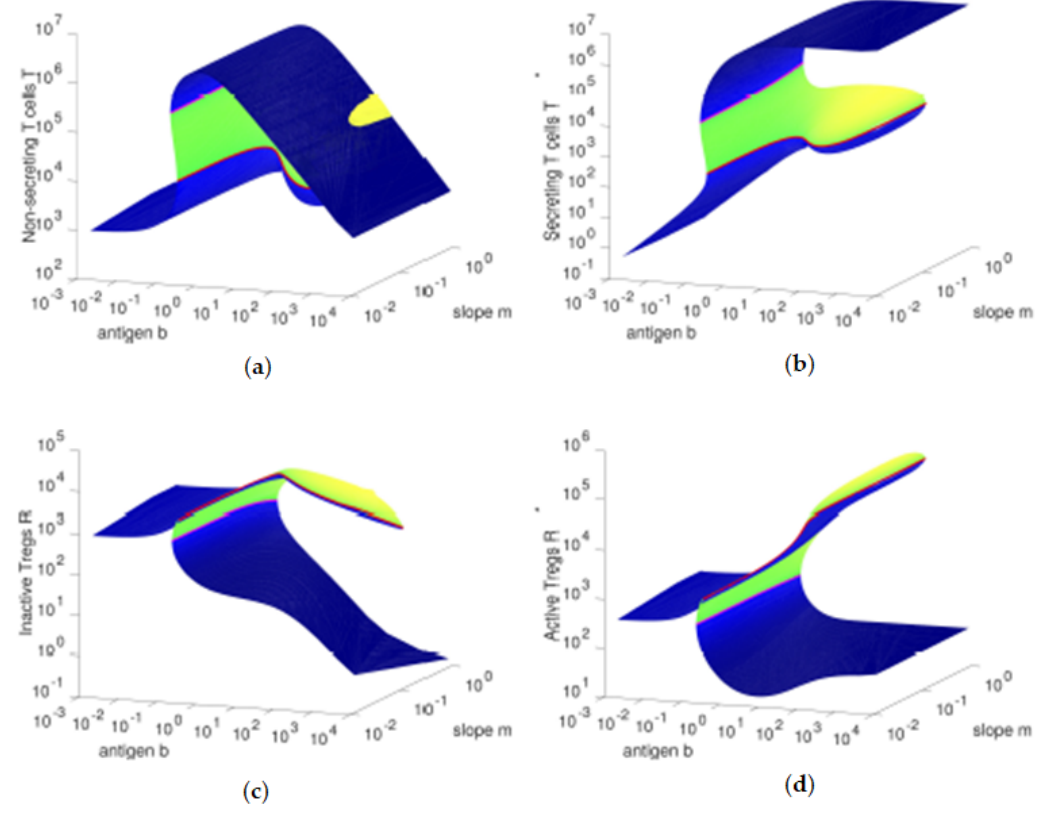
Figure 3. Equilibria manifold obtained from Theorem 1. Relationship between the antigenic stimulation b of T cells and ( a ) the concentration of non-secreting T cells T , ( b ) the concentration of secreting T cells T ∗ , ( c ) the concentration of inactive Tregs R , and ( d ) the concentration of active Tregs R ∗ . The axis pointing upwards to the right is the slope parameter m . The shading color indicates the real part of the largest eigenvalue Re ( λ ) , increasing from black to blue for stable equilibria, and from green to yellow for unstable equilibria. The red and the magenta lines show the bifurcations, when Re ( λ ) =